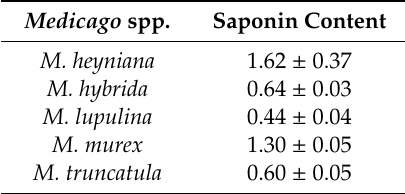
Table 1. Saponin content (% dry matter ± SD) in leaves of the five Medicago spp. Medicago